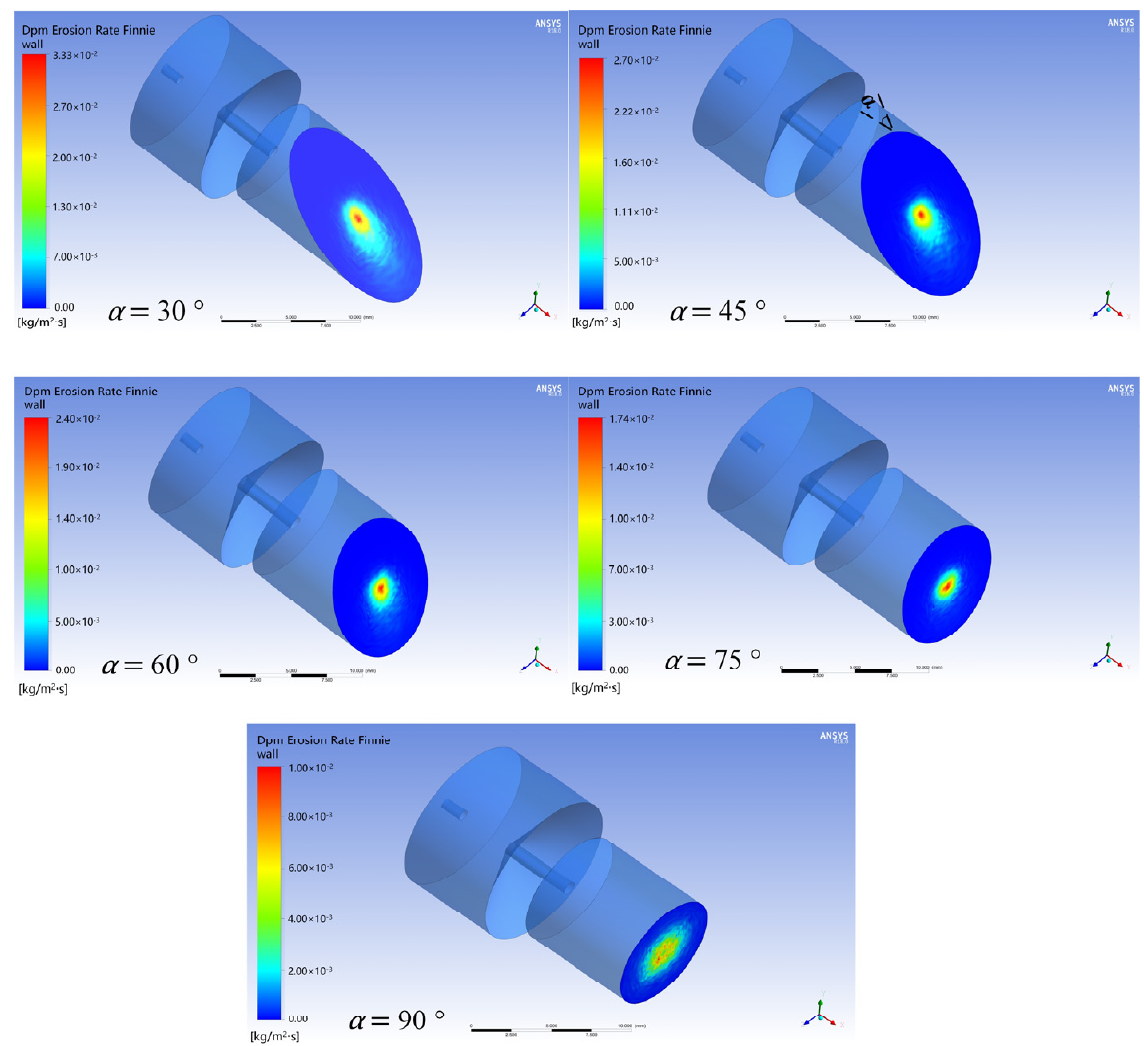
Figure 10. Processing Wall erosion distribution cloud by machining angle.